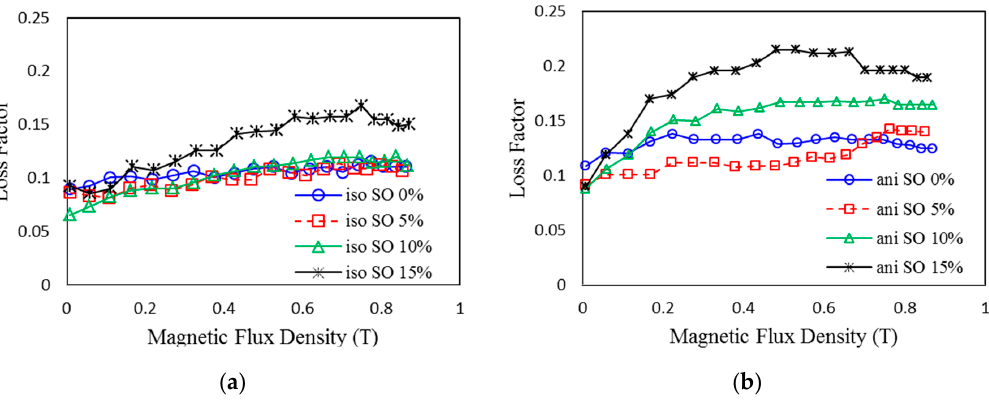
Figure 4. Loss factor of MRE with different contents of SO under different magnetic fields: ( a ) isotropic MRE and ( b ) anisotropic MRE.